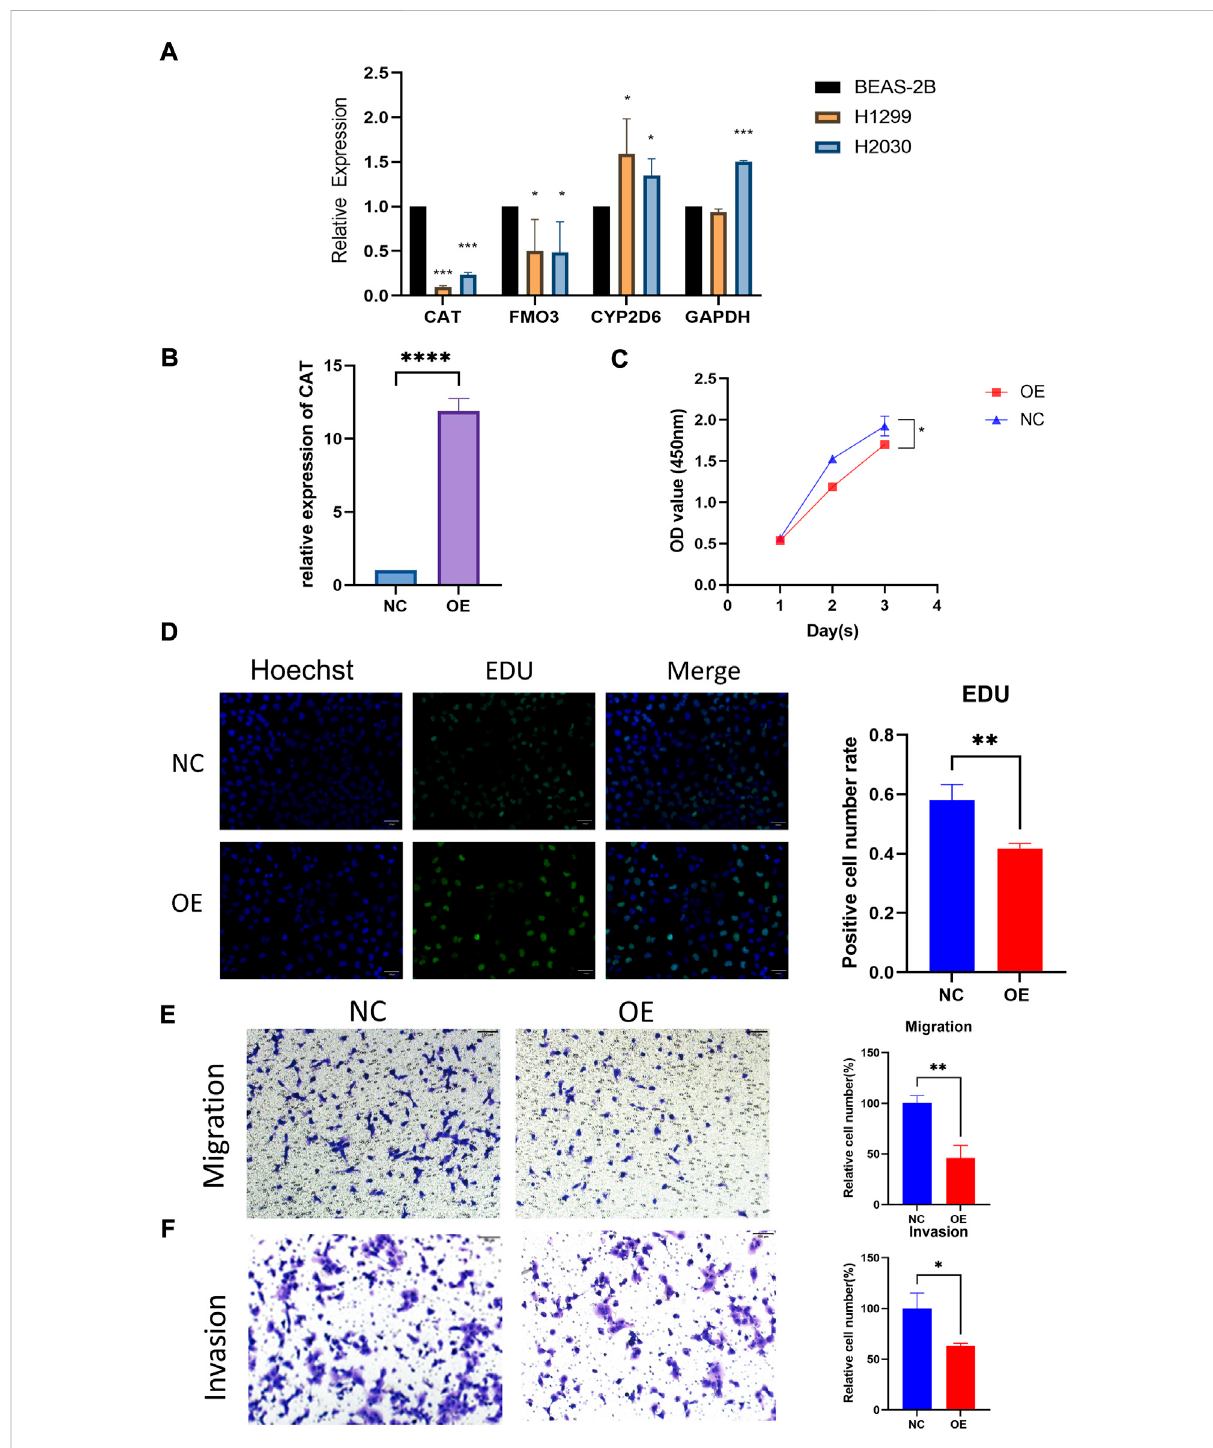
FIGURE 4 Functional veri fi cation of CAT. (A) Expression levels of four genes in cell lines. (B) Construction of CAT overexpression H1299. (C,D) CAT inhibited the proliferation function. (E,F) CAT inhibited the migration and invasion function. (* p < 0.05, ** p < 0.01, *** p < 0.001, **** p <